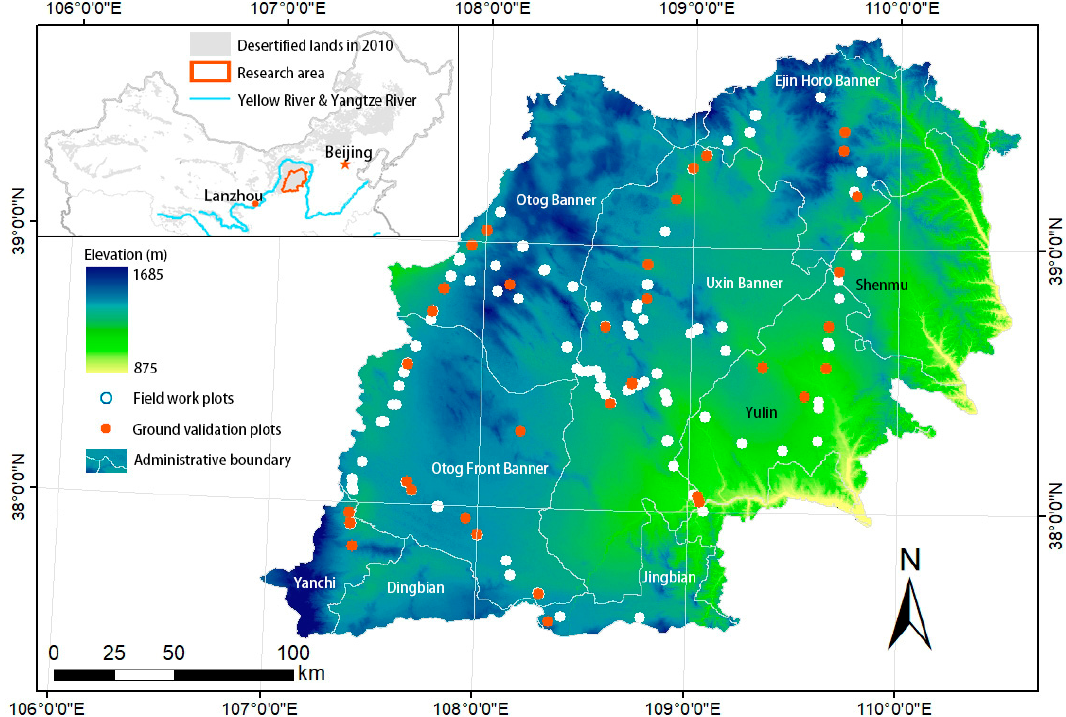
Figure 1. Elevation map of study area and locations of quadrat surveys (white and red points).